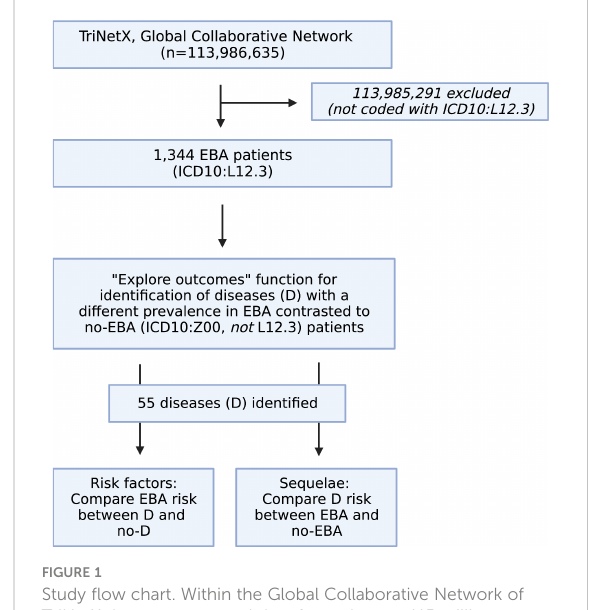
FIGURE 1 Study fl ow chart. Within the Global Collaborative Network of TriNetX that encompassed data from close to 115 million patients at the time of access (October 1 st , 2022), 1,344 patients with the diagnosis of epidermolysis bullosa acquisita (EBA), de fi ned by ICD10:L12.3 were identi fi ed. Patients without a diagnosis of EBA were excluded. Next, the “ explore outcomes ” function of TriNetX to identify diseases that are different in prevalence (at any given time) between EBA patients (de fi ned by presence of ICD10:L12.3) those without EBA (de fi ned as presence of ICD10:Z00 and absence of ICD10:L12.3). This identi fi ed 55 diseases with a different prevalence (at any given time) between EBA and no-EBA patients. Subsequently, 55 propensity-matched studies were performed to explore if any one of the identi fi ed diseases had an impact on subsequent EBA development. For this, patients with the disease, i.e., Crohn ’ s disease (ICD10:K50) were compared to those without the disease, i.g., no-Crohn ’ s disease (ICD10:Z00 and absence of ICD10:K50). Lastly, a propensity-matched study was performed to delineate the risk of EBA to develop any of the 55 identi fi ed diseases. Figure created with BioRender